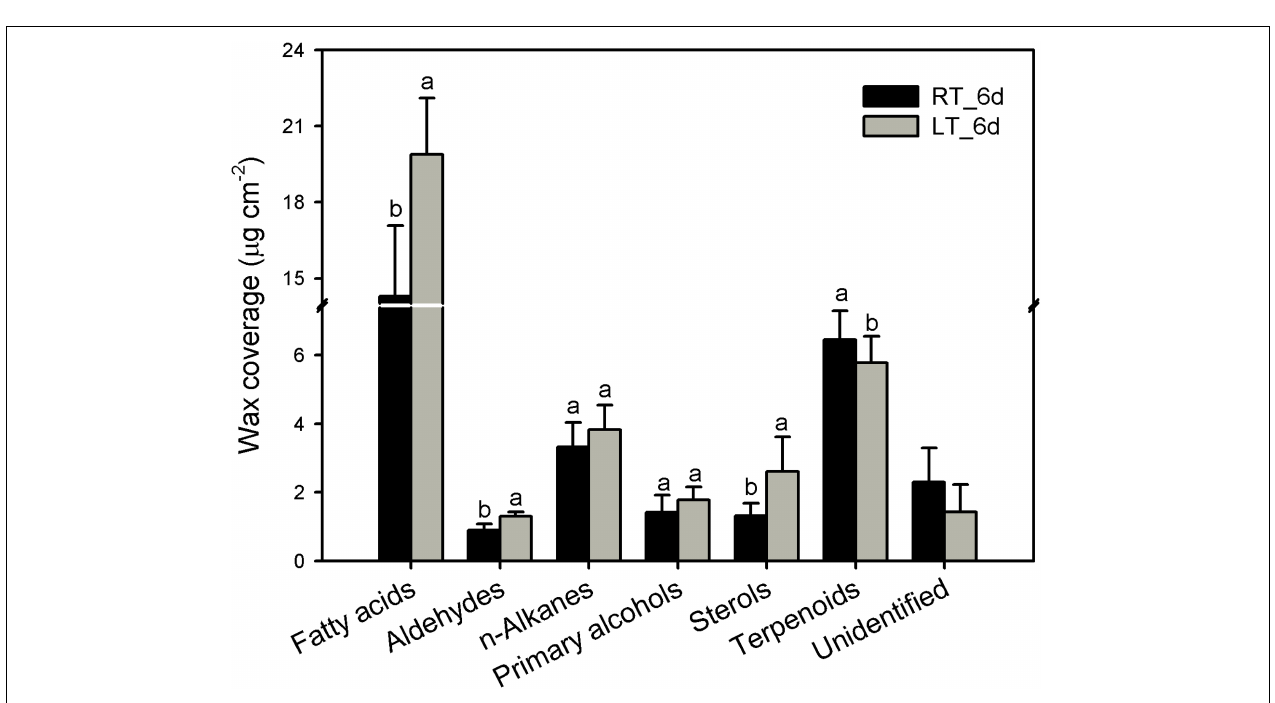
FIGURE 4 | Chemical compositions of cuticular waxes in banana fruit cuticle stored under 4 ◦ C and 25 ◦ C at 6 days. Data are given as mean ± SD ( n = 5). Letters indicate the significant differences at the 0.05 level.